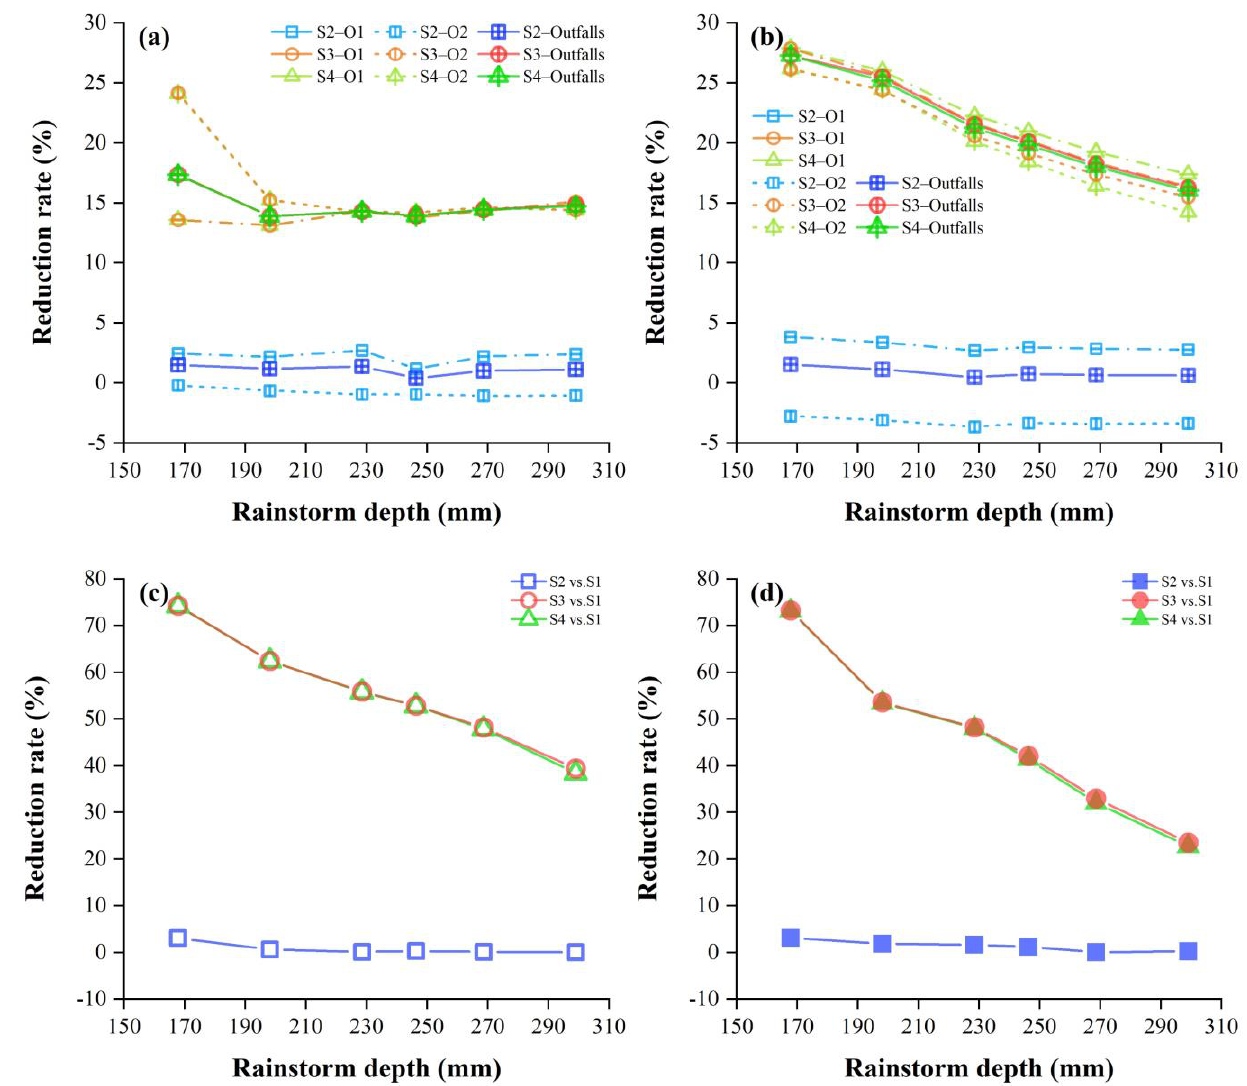
Figure 6. Reduction rate of the ( a ) peak flow at outfalls (O1 and O2), ( b ) total outfall flow at outfalls (O1 and O2), ( c ) overflow volume of junction nodes, ( d ) overflow cumulative duration of junction nodes for the discharge route scenarios (S2, S3, and S4) compared to the current status quo (S1) during rainstorms with 5–100–year return periods.